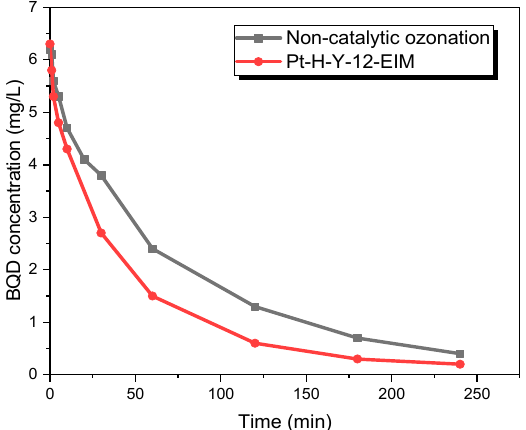
Figure 12. BQD concentration during the catalytic and non-catalytic ozonation of BQD. C BQD = 6 mg/L, C Acetonitrile = 6 mg/L, gas flow rate = 110 mL/min, T = 50 °C, stirring speed = 900 rpm, C O3,g = 21 mg/L, C catalysts = 0.5 g/L.